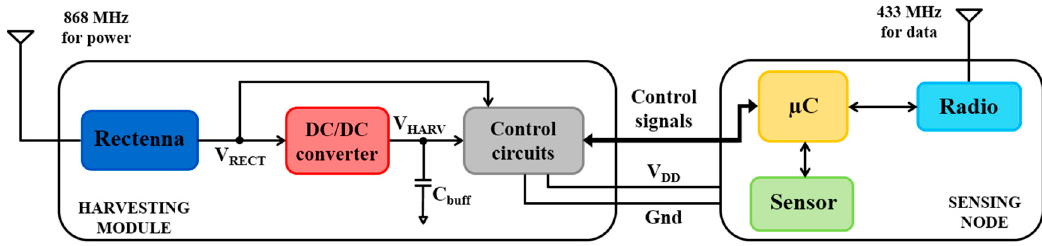
Figure 1. General scheme of the overall system.